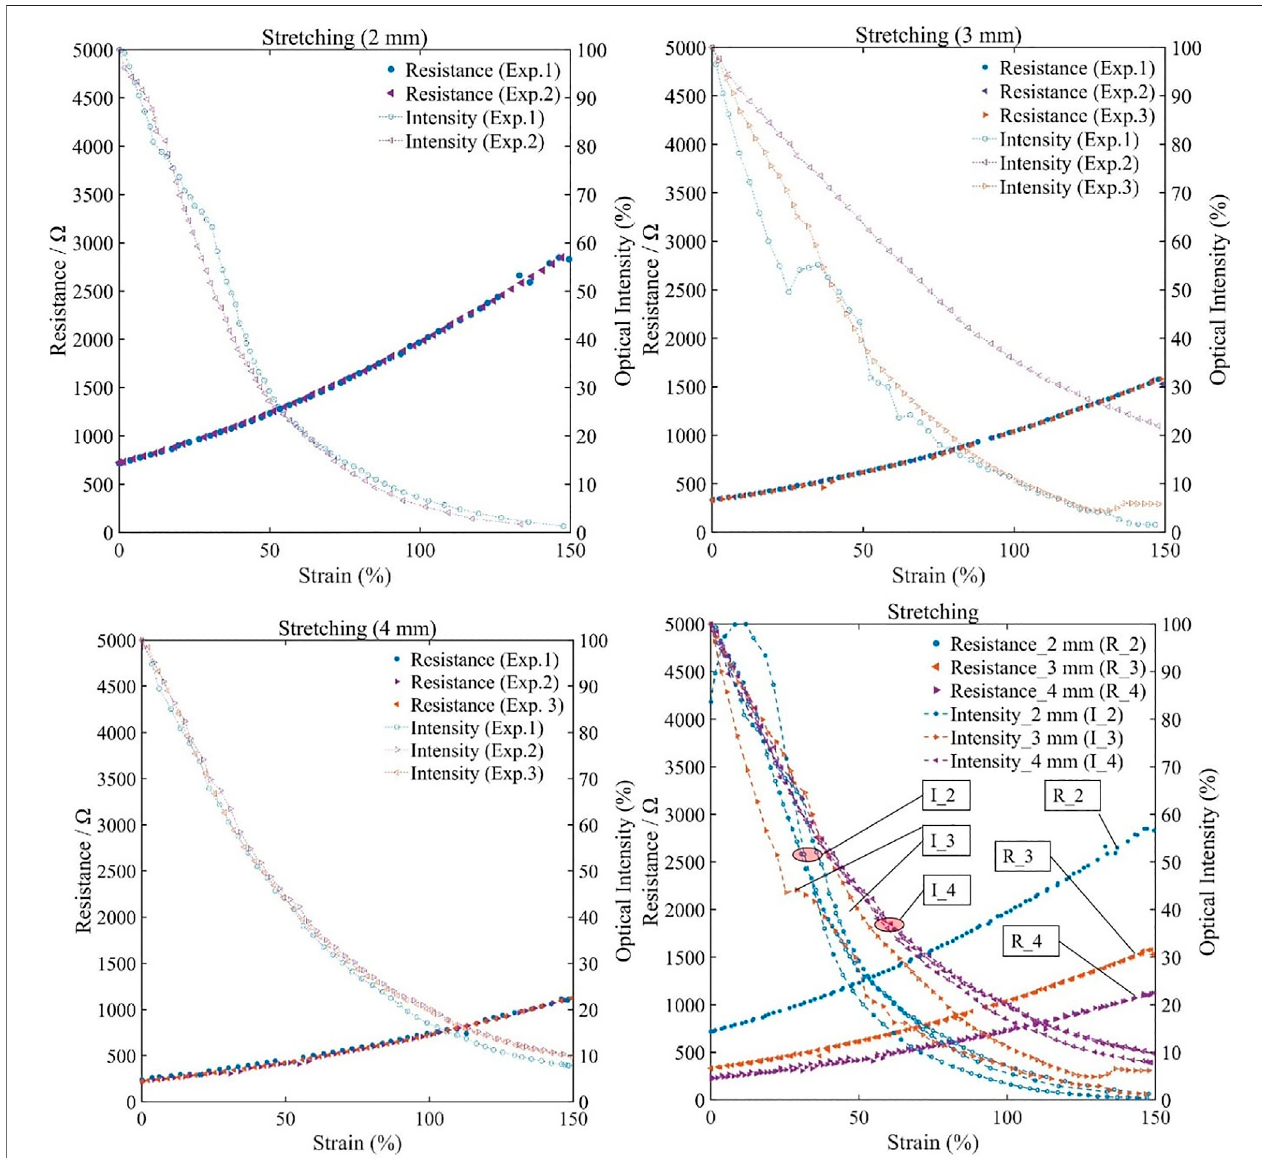
FIGURE 6 | Resistance and optical intensity performances of the MHS Sensor variation during stretching. (A) Resistance and optical intensity variation of 2-mm- diametersensorduringstretching. (B) Resistanceandopticalintensityvariationof3-mm-diametersensorduringstretching. (C) Resistanceandopticalintensityvariation of 4-mm-diameter sensor during stretching. (D) Comparison of performance of the MHS Sensor with three different diameters.